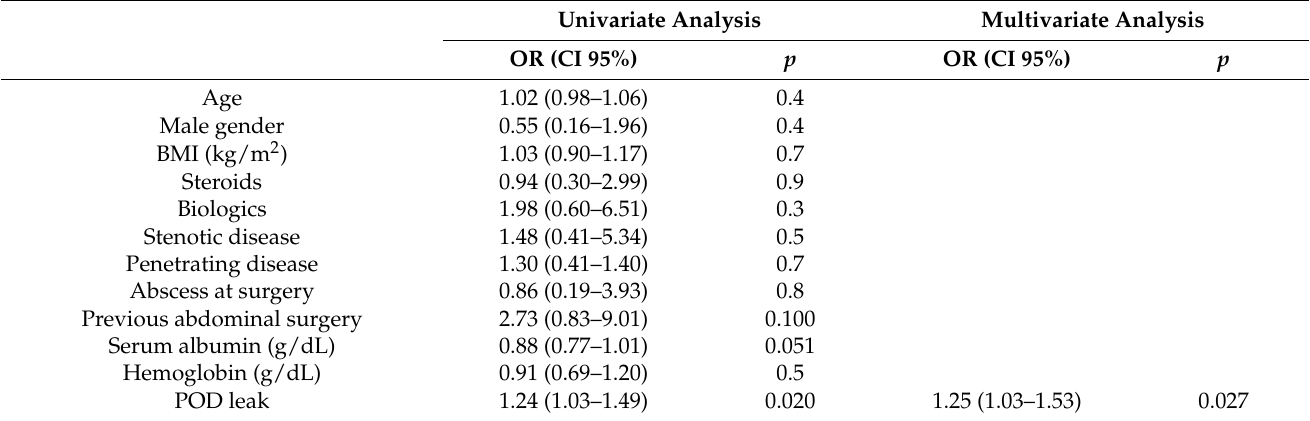
Table 2. Univariate and multivariate analysis of variables associated with percutaneous drainage. Univariate